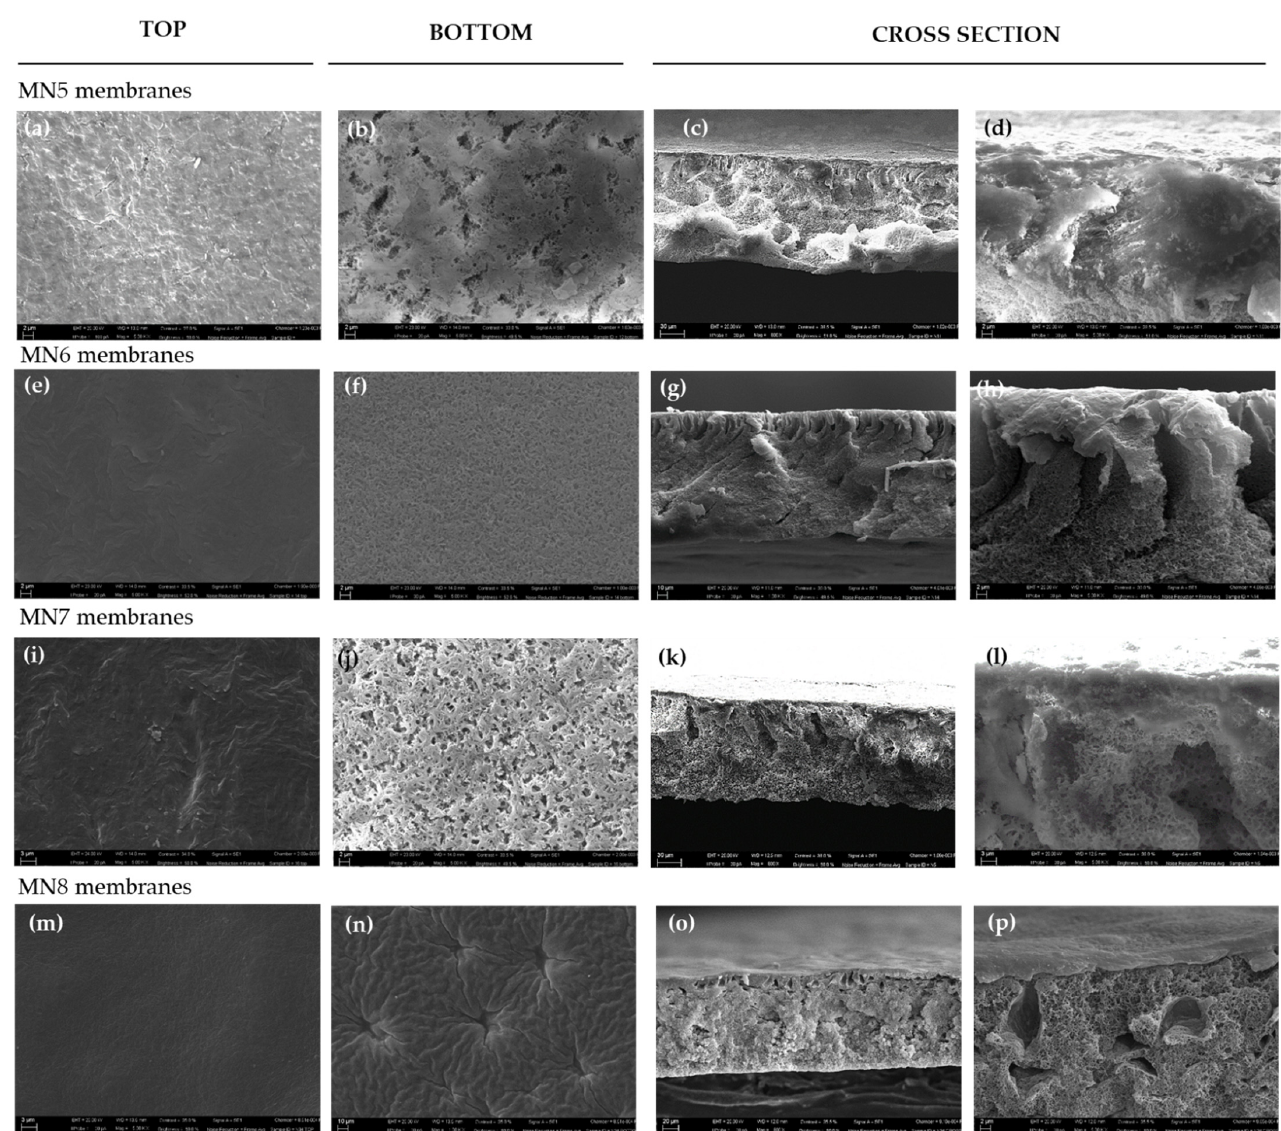
Figure 3. SEM images of membranes prepared with constant concentrations of PVDF (15 wt%) and PVPK17 (5 wt%) and different concentrations of PEG 200: ( a – d ) surface (top and bottom Mag. 5.00 KX) and cross-section (Mag. 800 X and 5.00 KX) of MN5; ( e – h ) surface (top and bottom Mag. 5.00 KX) and cross-section (Mag. 800 X and 5.00 KX) of the MN6; ( i – l ) surface (top and bottom Mag. 5.00 KX) and cross-section (Mag. 800 X and 5.00 KX) of MN7; and ( m , o , p ) surface (top and bottom Mag. 5.00 KX), ( n ) surface (bottom Mag. 1.00 KX) and cross-section (Mag. 800 X and 5.00 KX) of MN8. The effects of higher and lower polymer concentrations (18 wt% and 10 wt%) on